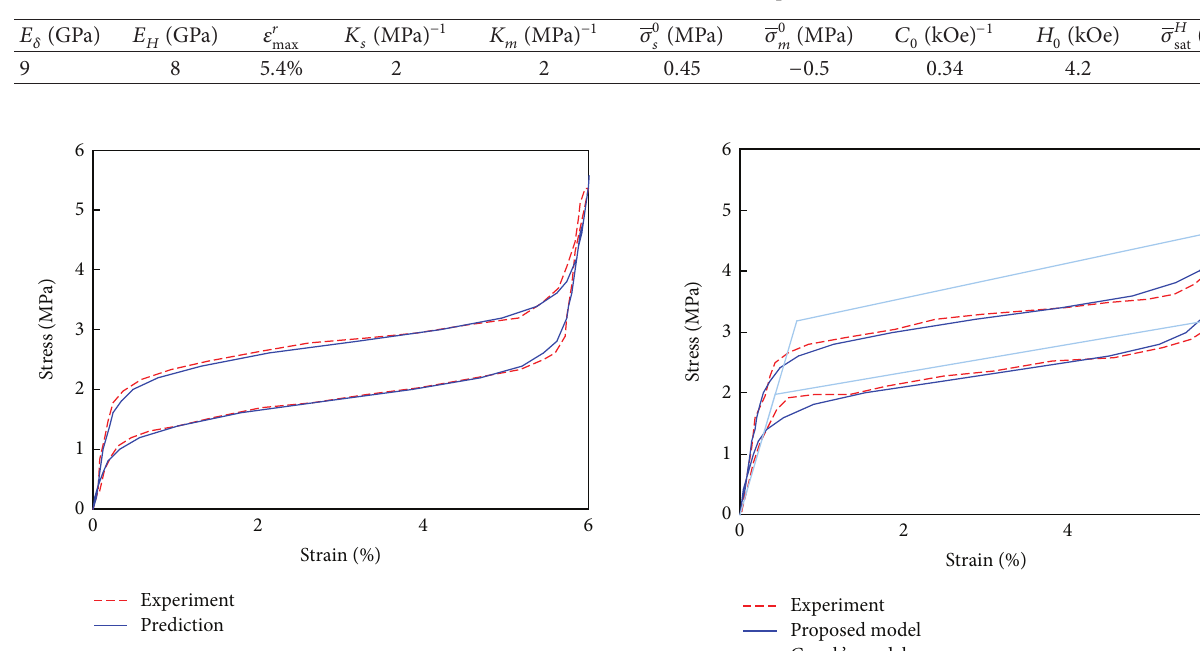
Table 1: Material constants measured from experiments [17].